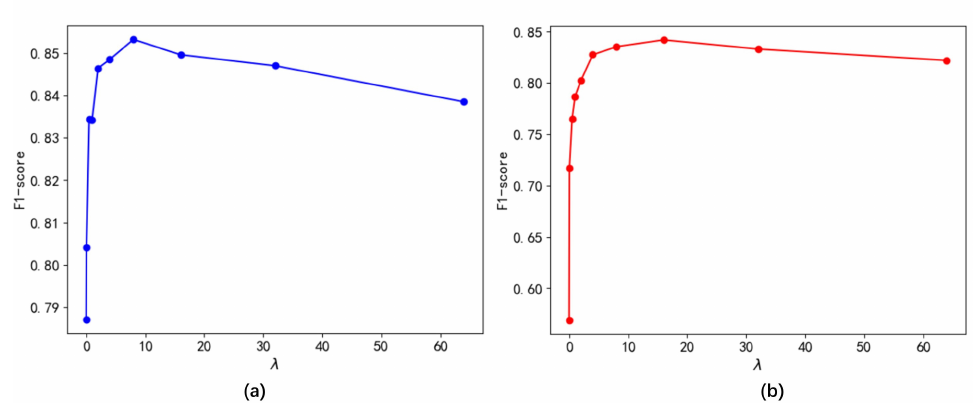
Figure 10. Effects of semi-supervised loss weights λ . ( a ) LEVIR2000 dataset. ( b ) WHU dataset.